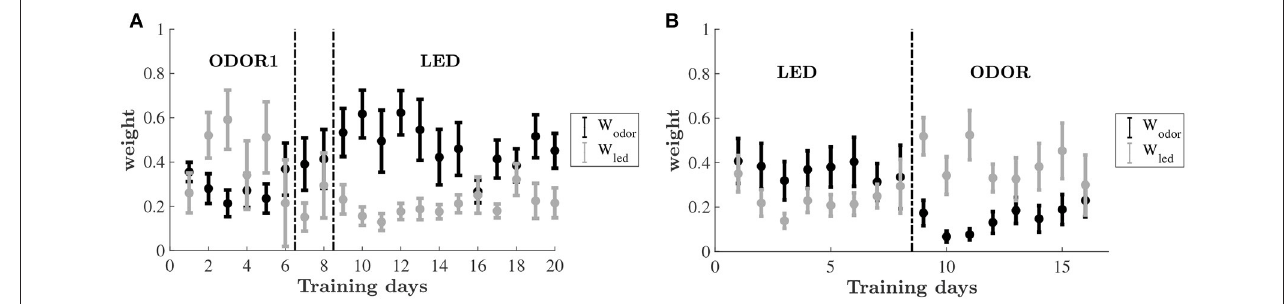
FIGURE 5 | Estimated decision weights on odor and LED color by training days. Average by animal ± SEM . The sets are the same as in Figure 2 . (A) Relative decision weights on the odor (black) and LED color (gray) dimensions on the odor-first group. (B) Relative decision weights on the odor (black) and LED color (gray) dimensions on the LED-first